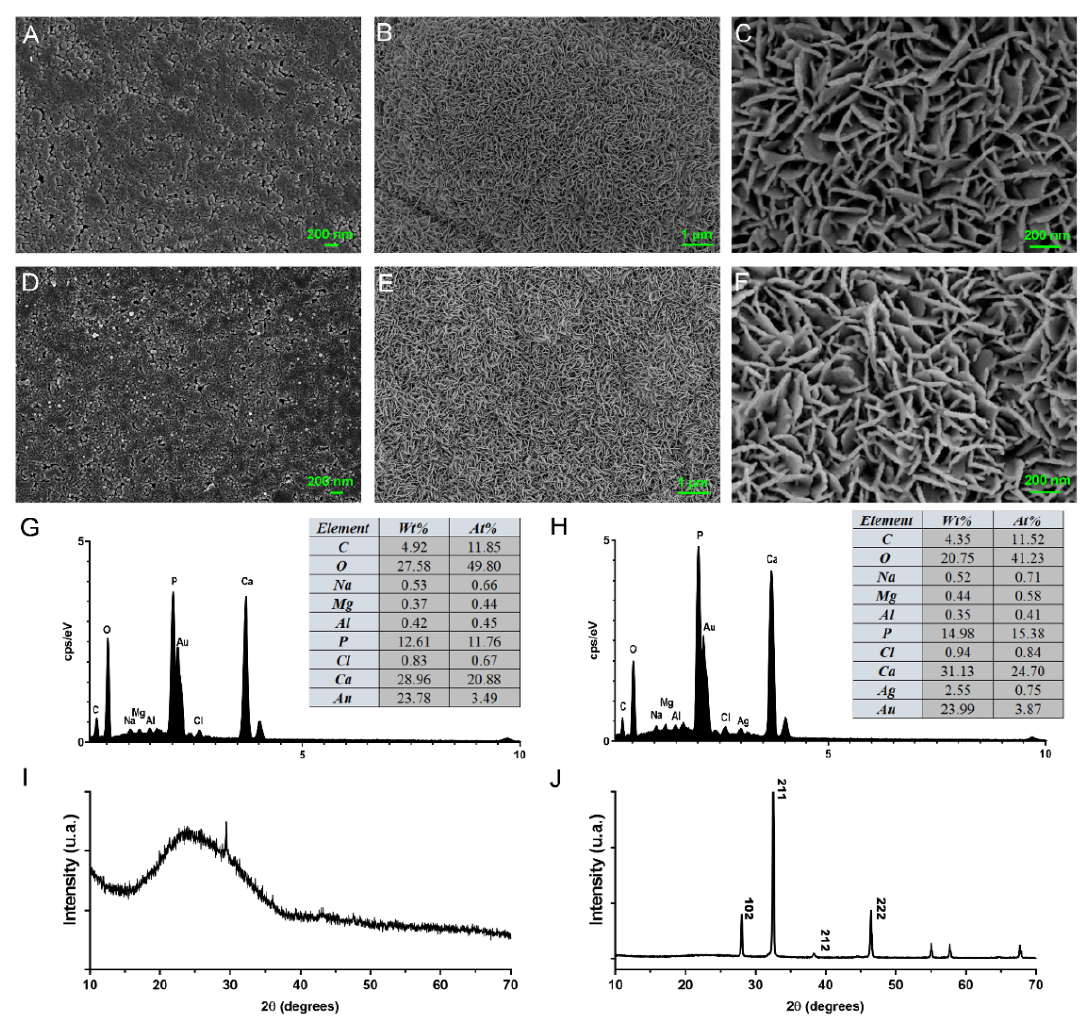
Figure 13. In vitro mineralization of MCSNs and M-AgTX. ( A , D ) FE-SEM image of original MCSNs and M-AgTX tablets surfaces, respectively; ( B , C ) FE-SEM image of MCSNs tablet surface after being soaked in SBF for 7 days ( B ) × 10,000, ( C ) × 50,000); ( E , F ) FE-SEM image of MCSNs tablet surface after being soaked in SBF for 7 days ( E ) × 10,000, ( F ) × 50,000; ( G , H ) EDS spectrum of crystals formed on MCSNs and M-AgTX tablets surfaces after being soaked in SBF for 7 days, respectively; ( I , J ) Wide-angle XRD patterns of M-AgTX before and after being soaked in SBF for 7 days.